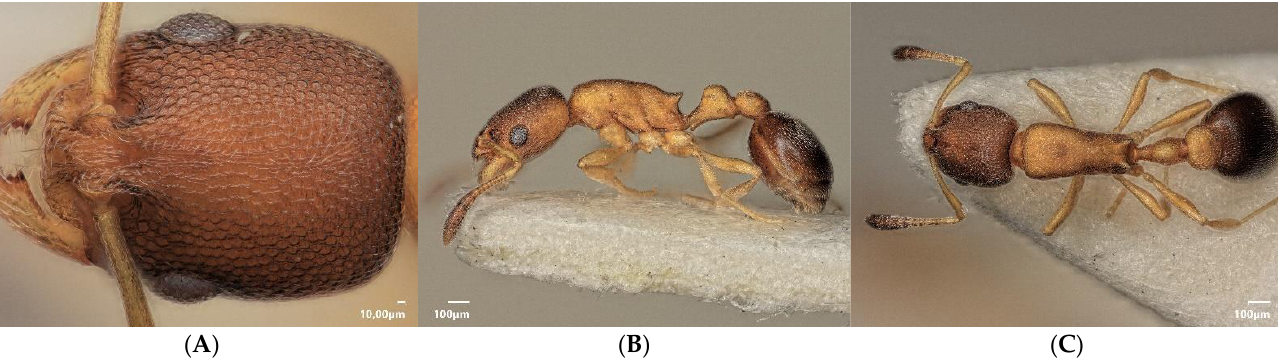
( C ) Figure 4. Cardiocondyla tjibodana : head in dorsal view ( A ), lateral view ( B ) dorsal view ( C ) ( A ) ( C ) Figure 5. Cardiocondyla schulzi , holotype: head in dorsal view ( A ), lateral view ( B ), dorsal view ( C ).